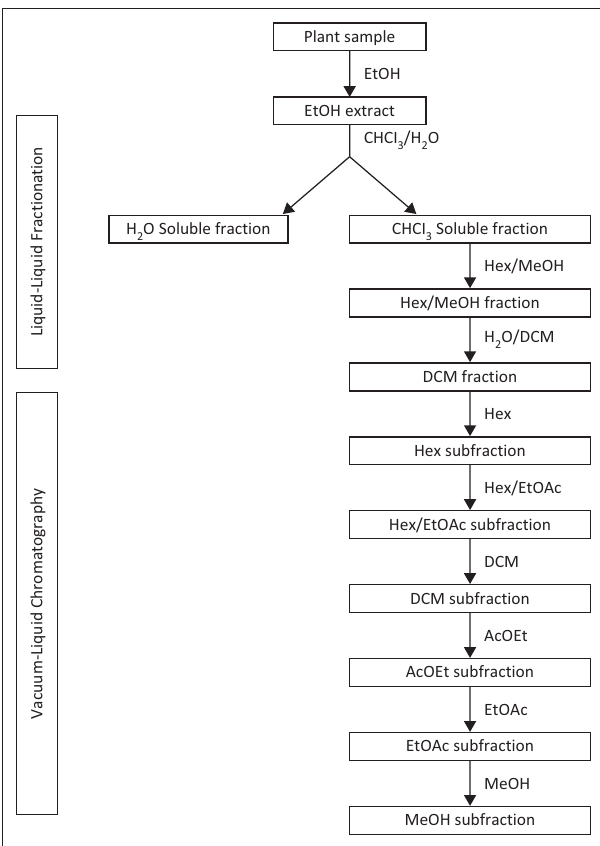
FIGURE 2: Schematic presentation summarising the extract preparation and purification of the fractions. AcOEt, acetone; DCM, dichloromethane; EtOAc, ethyl acetate; EtOH, ethanol; CHCl MeOH,